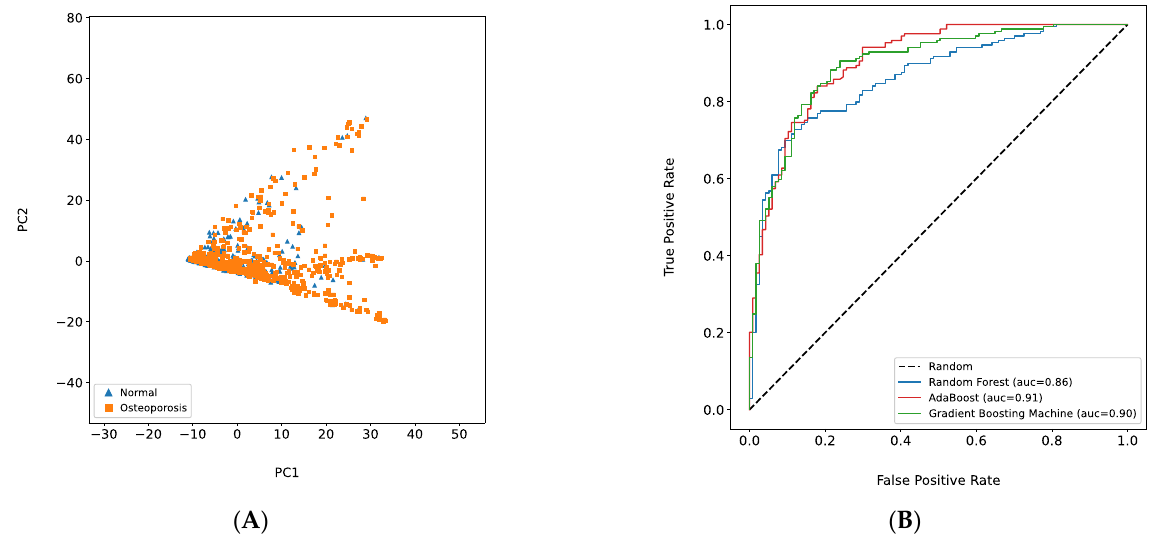
Figure 2. Draft Model Performance. A: The result of principal component analysis plot based on 1151 features. GBM — Gradient Boosting Machine. B: Receiver operating characteristic (ROC) curve for three different best models (Random Forest, AdaBoost, and Gradient Boosting Machine) based on total features (the number of features = 1151).